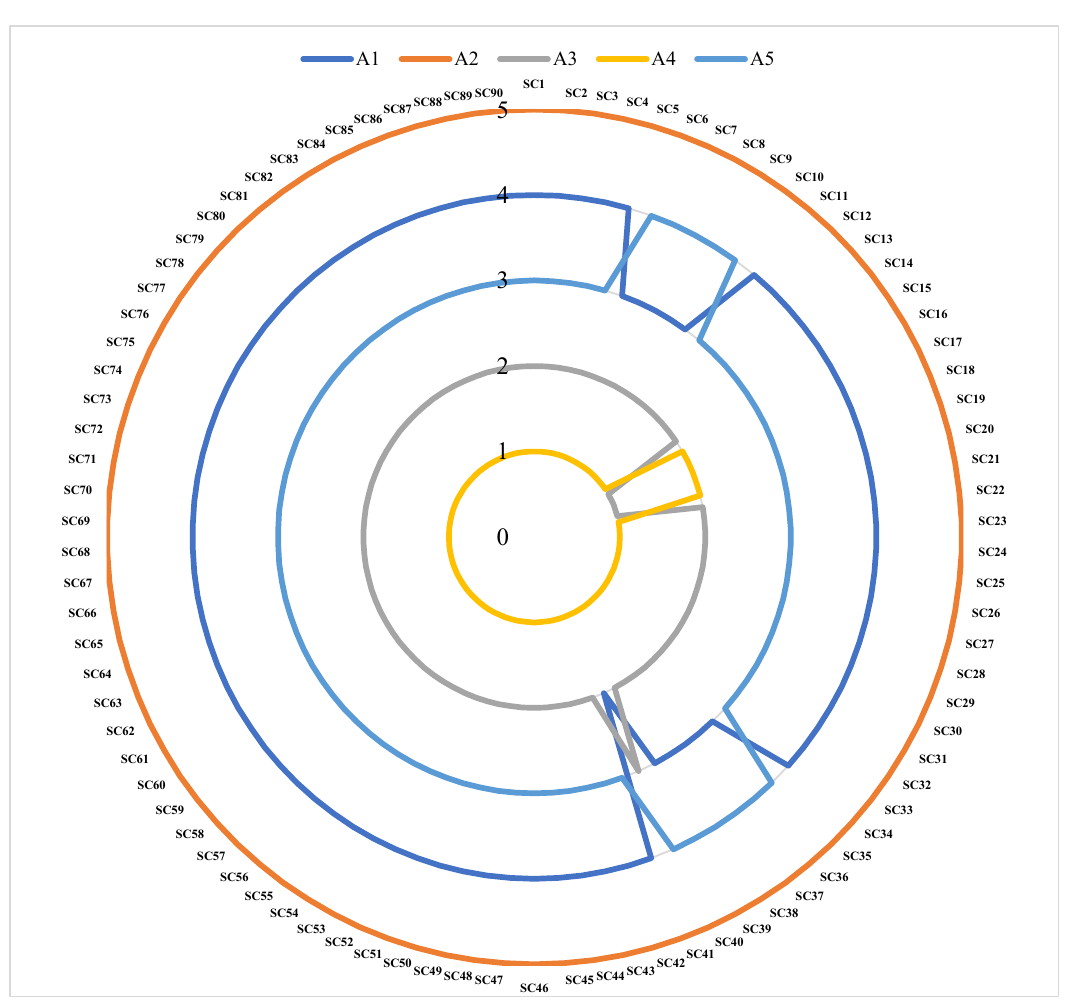
Figure 1. Impacts of the changing criteria weights concerning 90 scenarios.